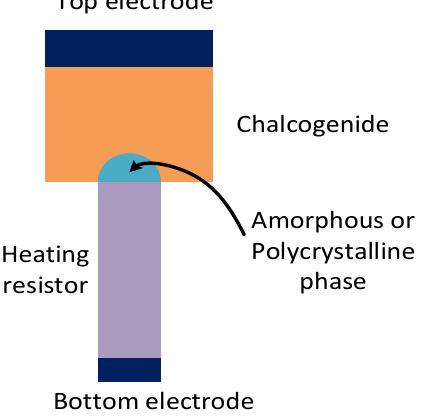
Figure 18. A basic phase change memory cell structure.